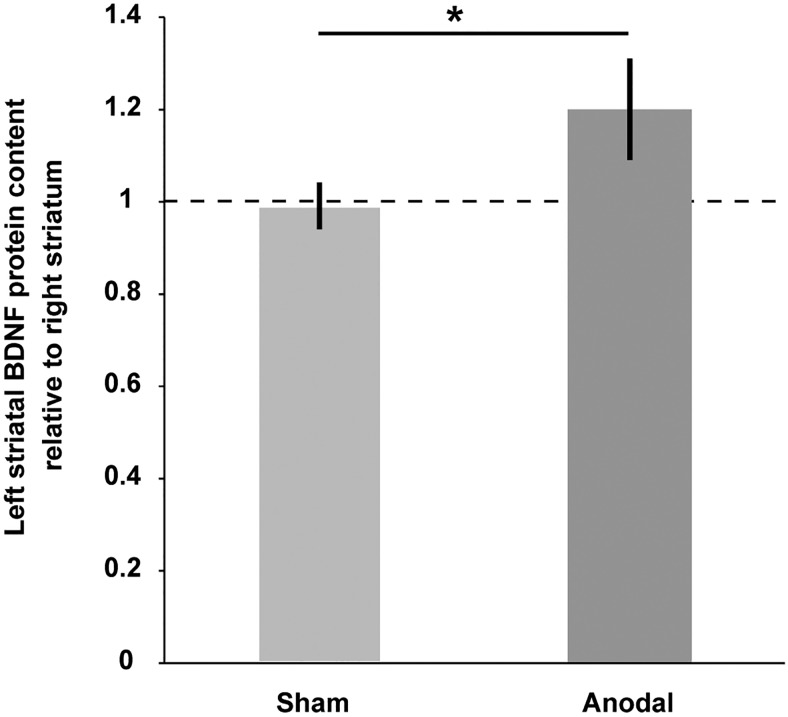
Anodal DCS applied to the left motor cortex enhanced ipsilateral striatal BDNF protein expression in naive rats. Left striatal BDNF protein content is normalized to the content of the contralateral nonstimulated striatum (1 = 100%) and compared between the two DCS stimulation conditions [sham DCS (n = 7) and anodal DCS (n = 9)]. Mean ± SEM; two-tailed Student’s t test; *p < 0.05.